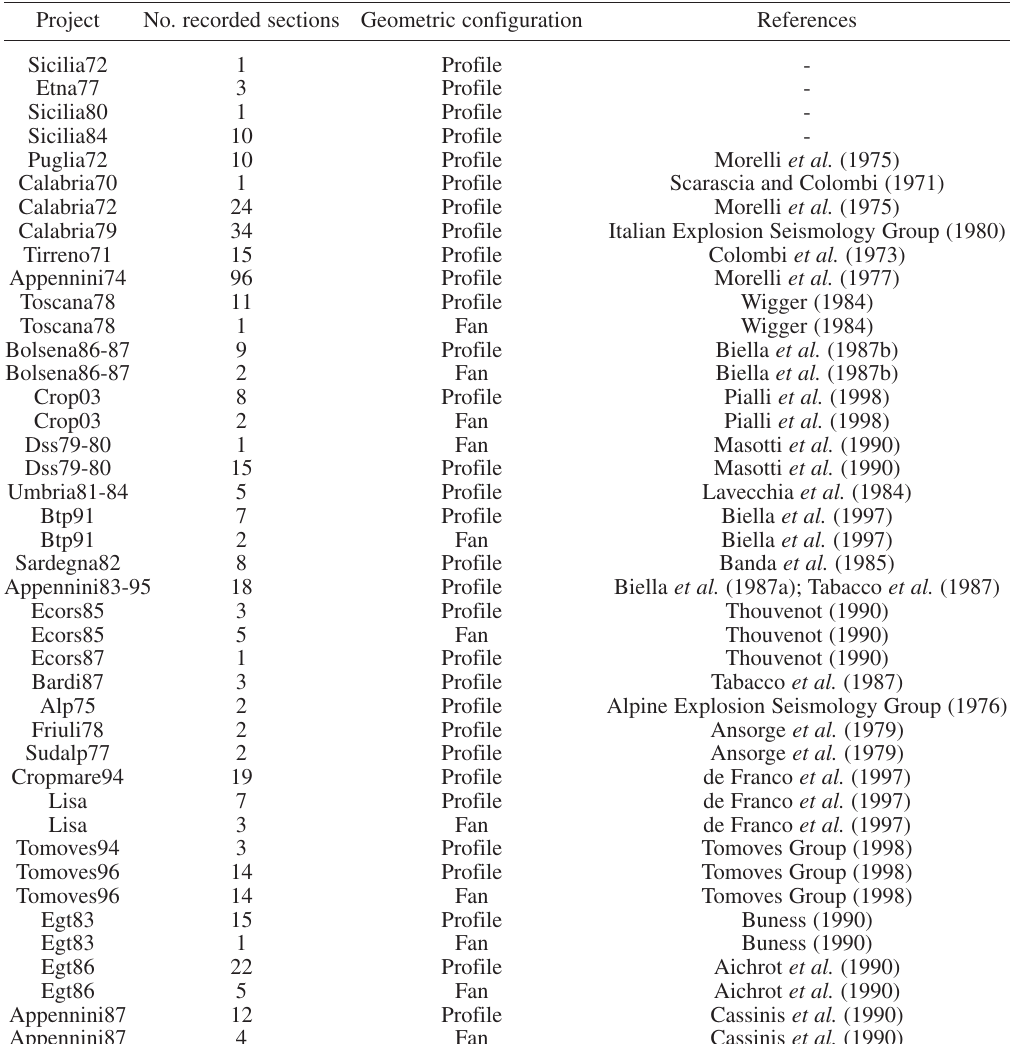
Table I. Number of the seismic sections recorded in each of the project and used in revision carried out and geometric configuration used for data acquisition. The last column lists the main references connected with the